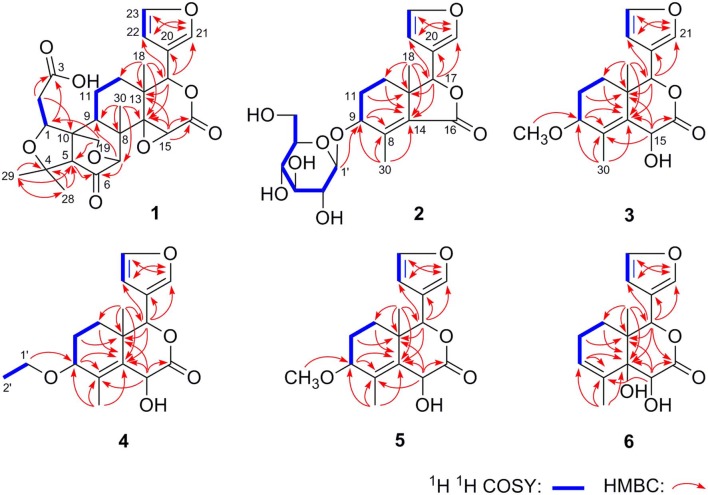
The main 1H 1H COZY and HMBC correlations of 1–6.